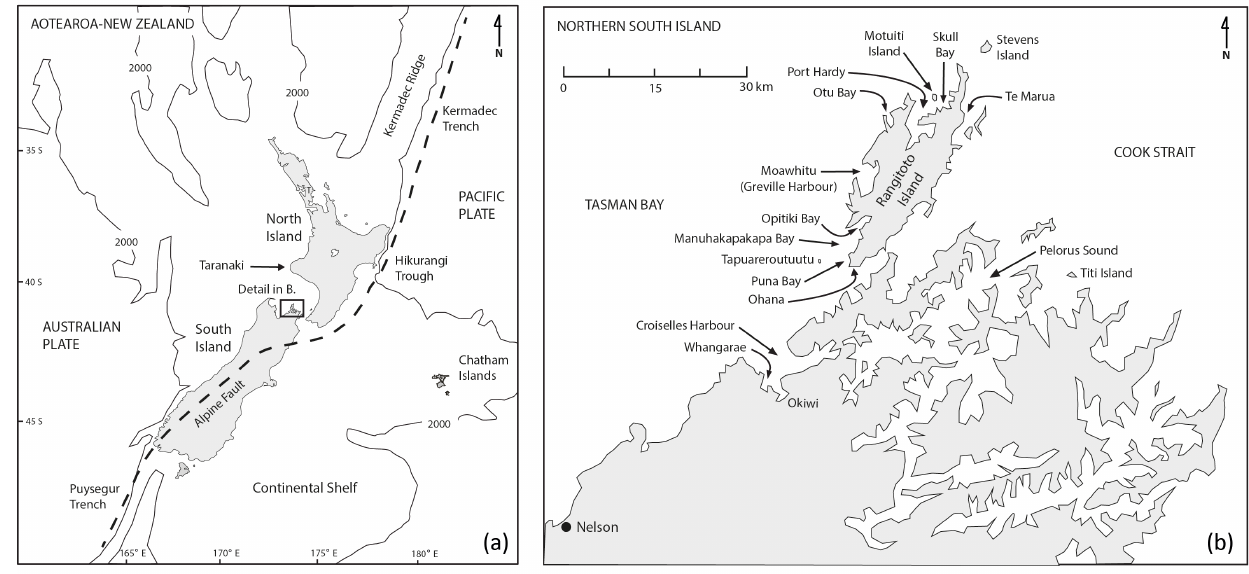
Figure 1. (a) Aotearoa-New Zealand’s tectonic location in the South Pacific showing the Australian–Pacific plate boundary as a dashed line. The submerged continental shelf boundary is loosely defined by the 2000m isobaths (adapted from Carter et al., 1988). (b) Rangitoto Island (D’Urville Island) and surrounding locations mentioned in the